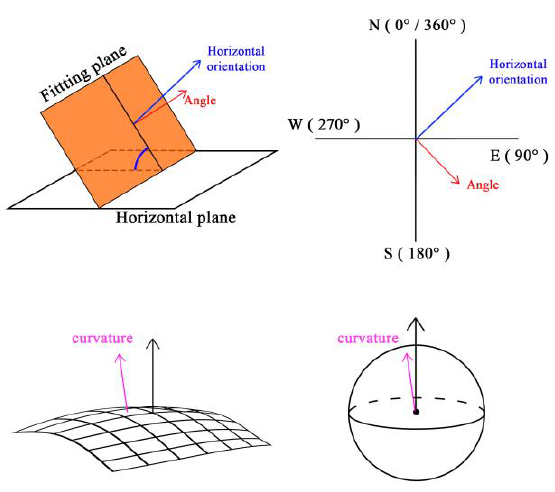
Figure 2 . 3D pose-varied semantics of